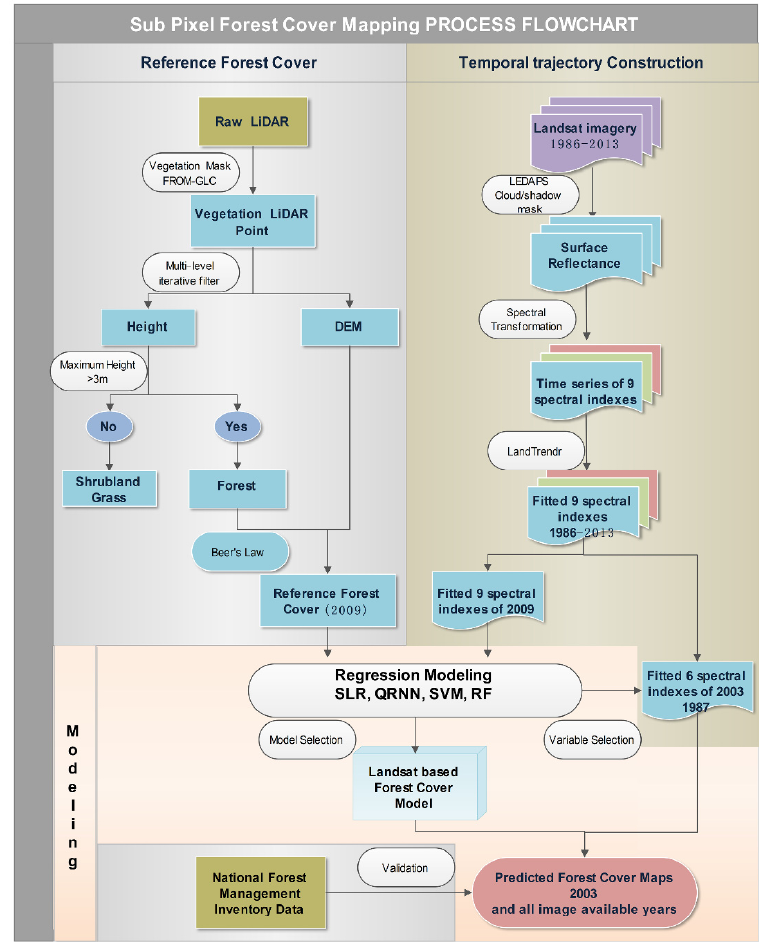
Figure 2. Flowchart for the sub-pixel forest cover process.